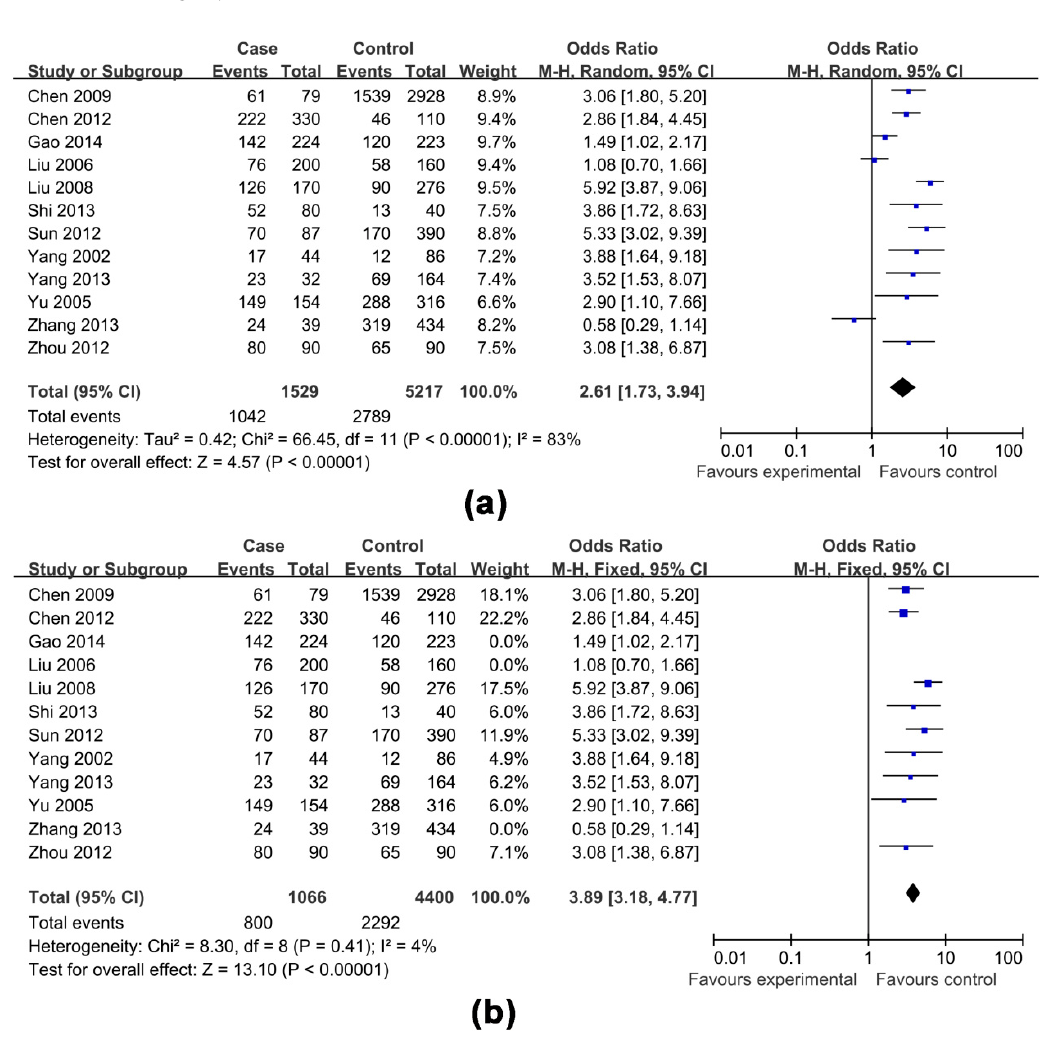
Figure 4. Effects of possible risk factors in chronic HBV-infected patients: ( a ) smoking; and ( b ) smoking adjusted.